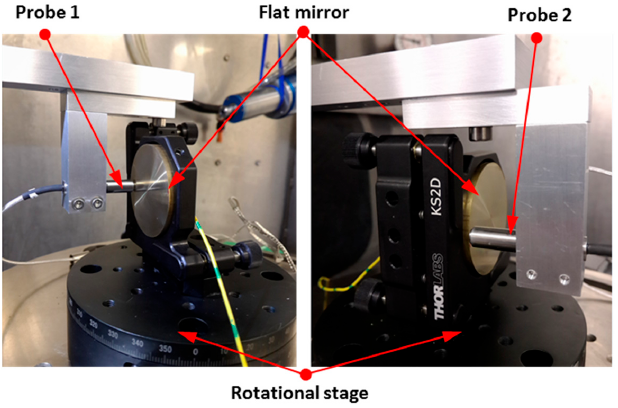
Figure 7. Experimental setup of the E ZX measurement using the reversal method.